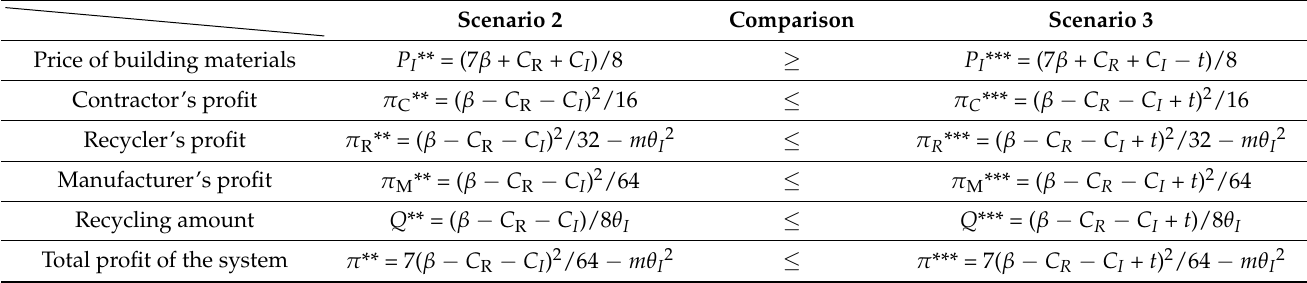
Table 3. Comparison of scenario 2 and scenario